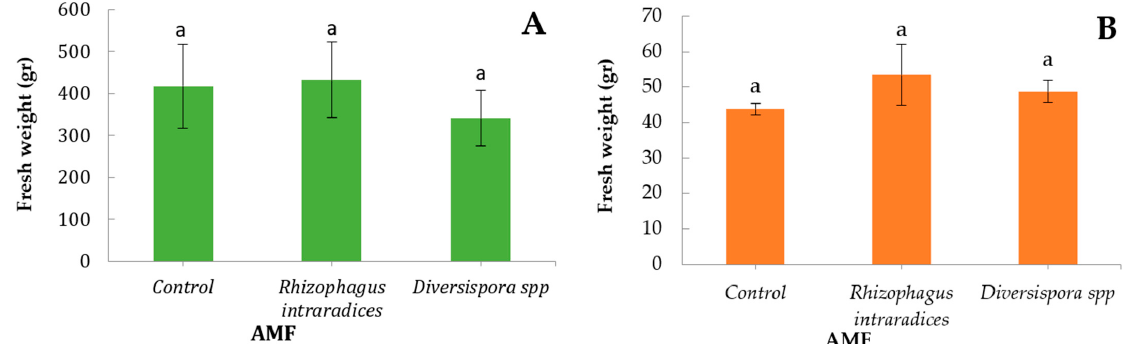
Figure 1. Yield of lettuce ( A ) and green onion ( B ) after application of two arbuscular mycorrhizal inocula ( R. intraradices or Diversispora spp.) or without (control). Bars (average values ± SE) followed by different letters indicate significant differences ( p < 0.05).